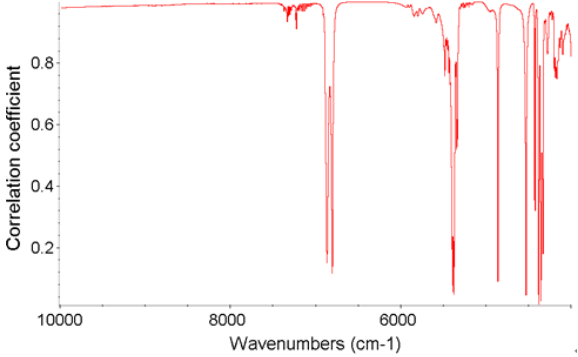
Fig. 3. Correlation spectrum of coptis and lactose binary mixture.